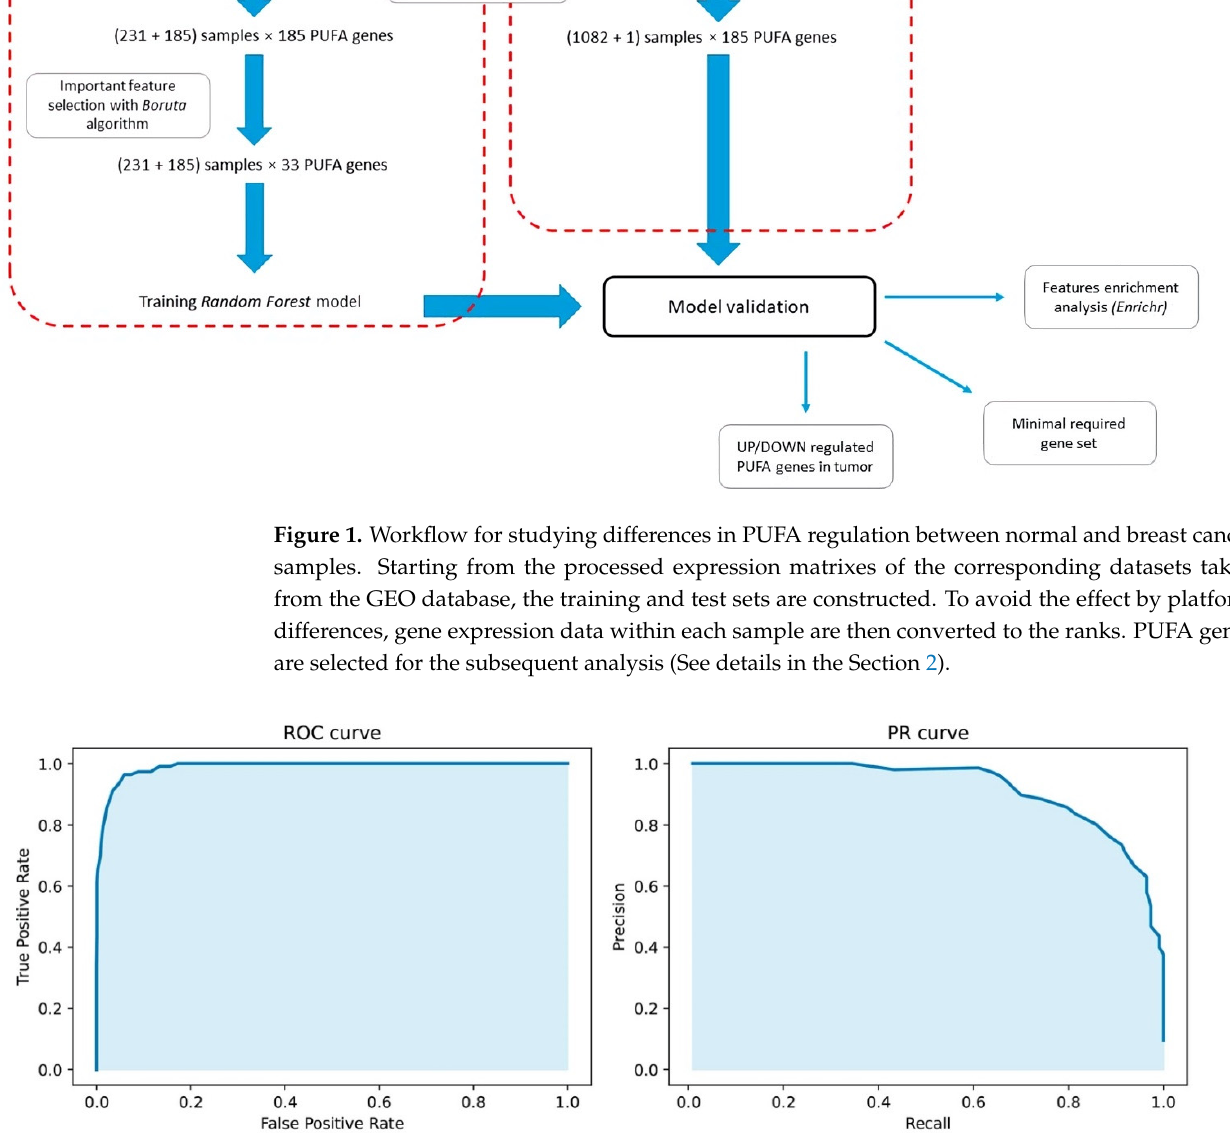
Figure 2. ROC and PR metrics for dichotomic classification of breast cancer samples and normal ones.